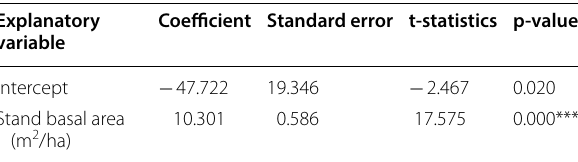
Table 7 Linear regression analysis result of stand basal area and AGB